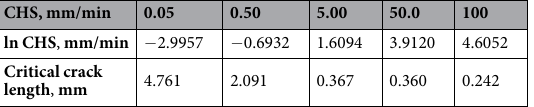
Table 3. Critical crack length of sharp notched HDPE at various crosshead speeds.